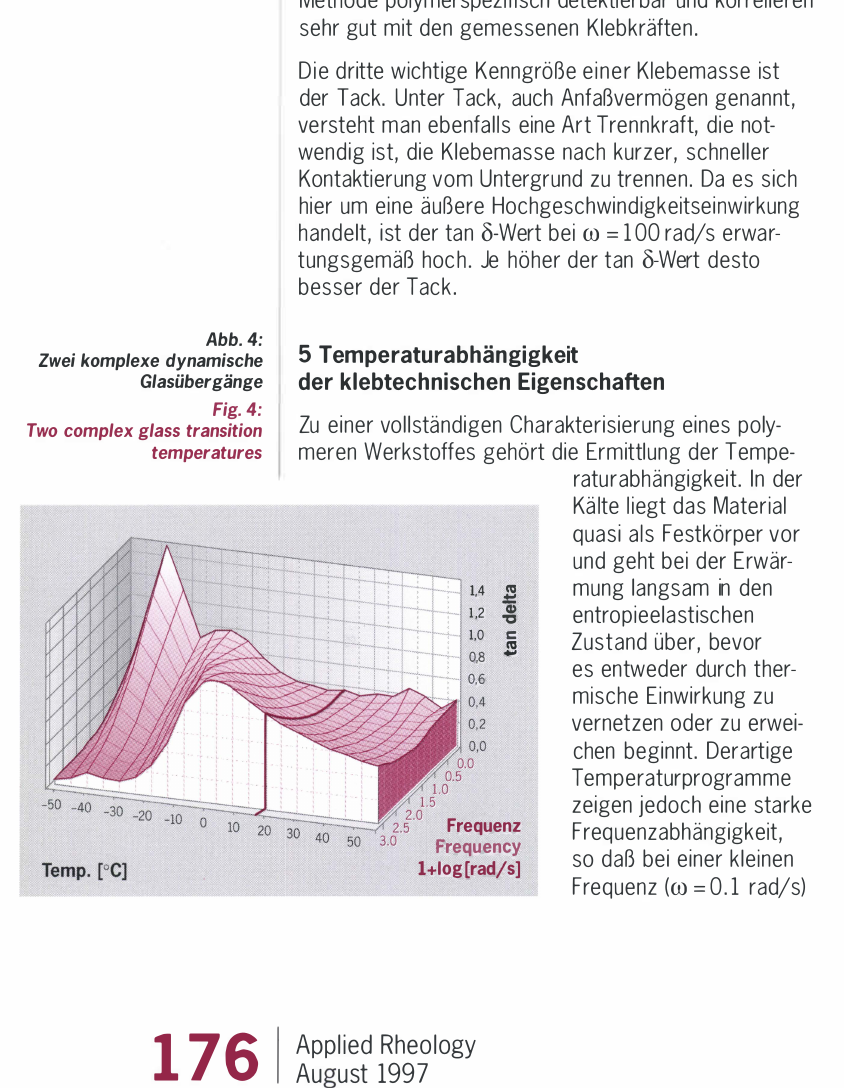
Frequency dependence of